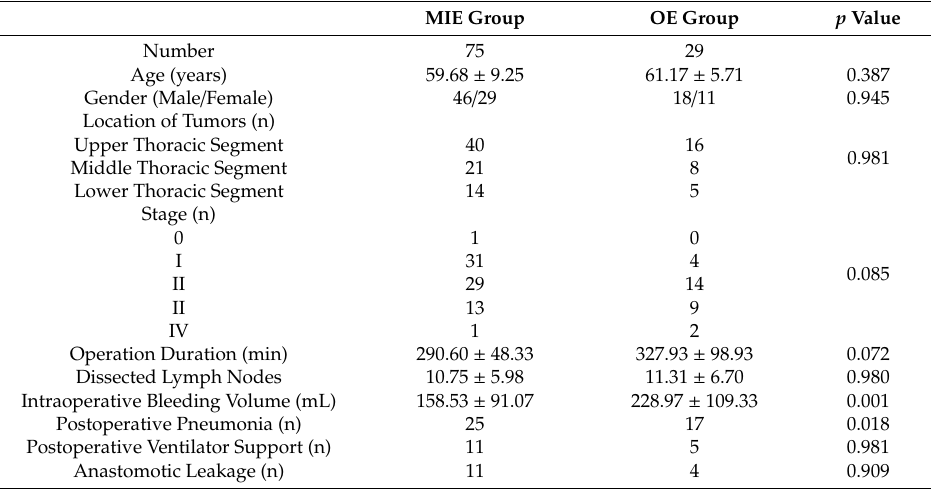
Table 1. Basic clinical characteristics of